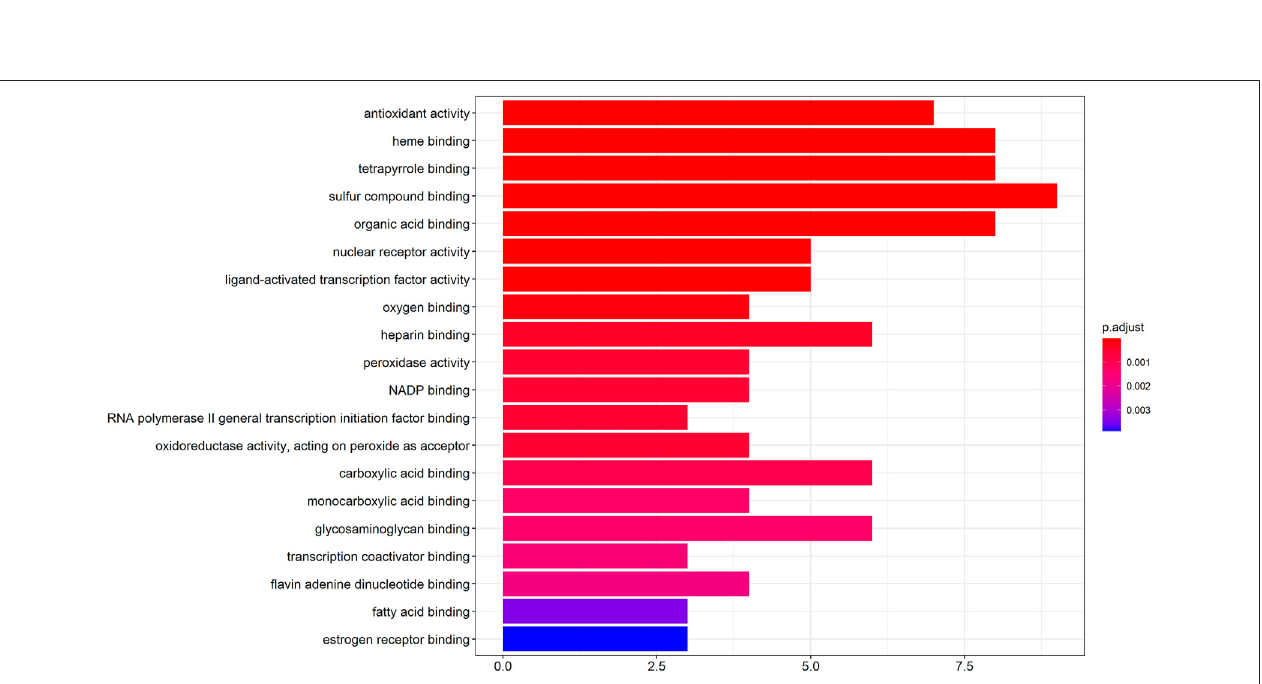
FIGURE 2 | GO enrichment analysis of hepatotoxic target.